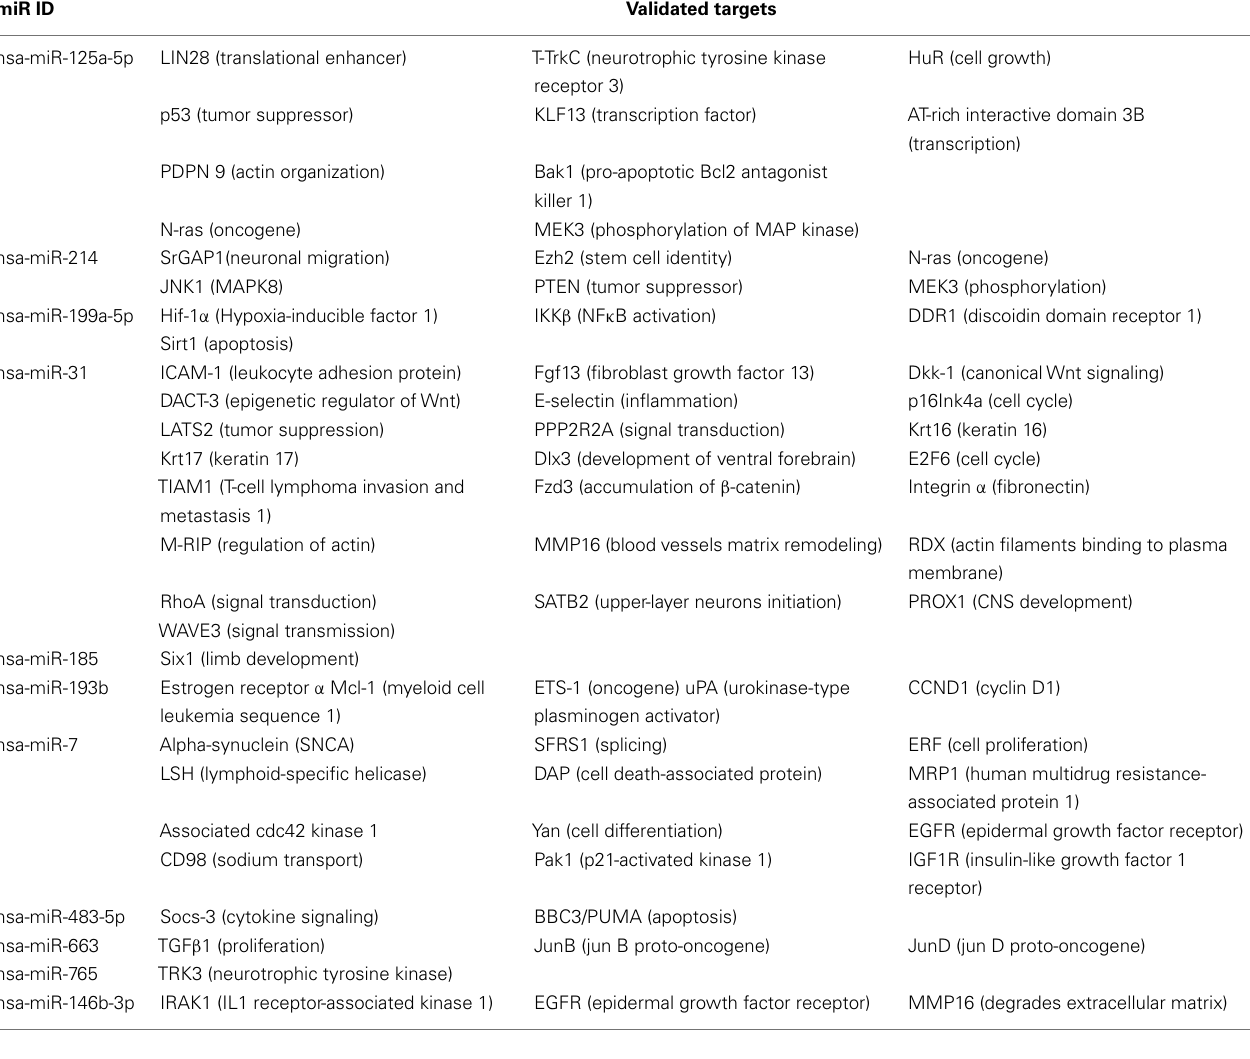
Table 3 |Additional targets of BChE-targeting